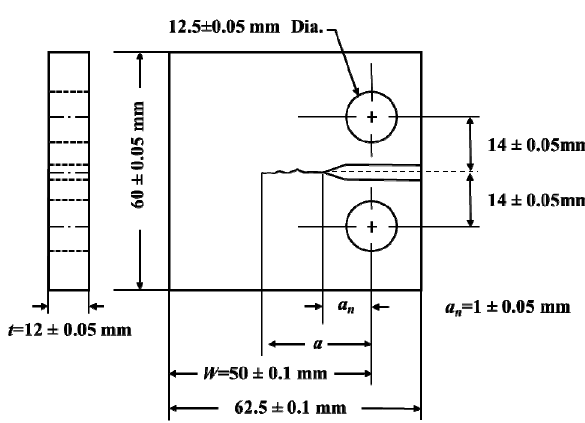
Figure 1: Geometry of the test CT specimen [19].